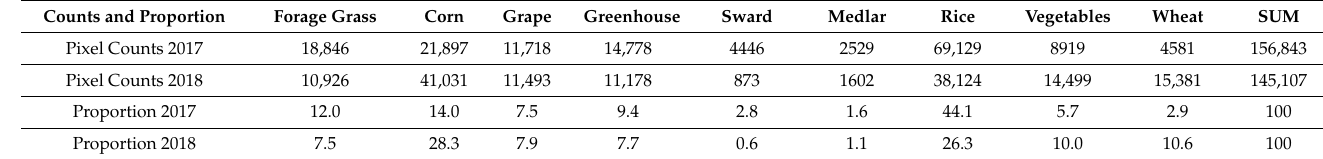
Table 2. The number of training samples for S-2 at 10 m and the proportion for each crop type.